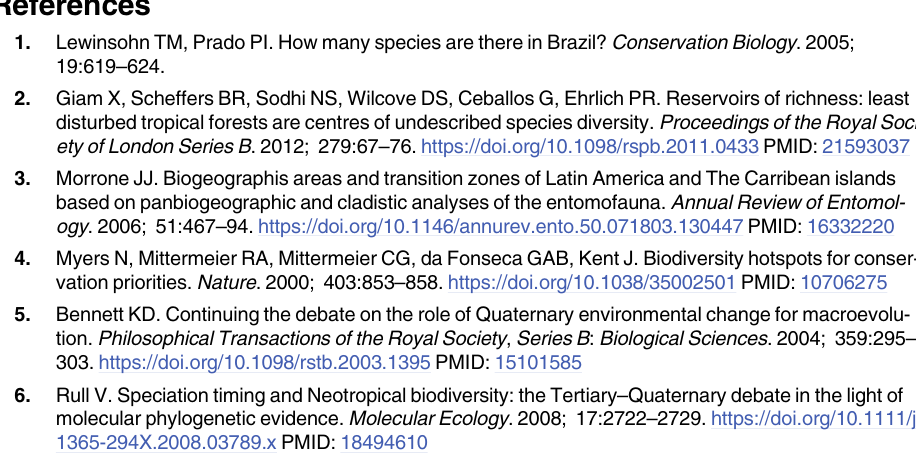
S14 Table. Estimates of relative contributions of each of the employed environmental vari- ables to the ENMs reconstructed for each of the three species of the M . projectans complex. S15 Table. Pairwise values of abiotic niche overlap estimated among the three species of the M . projectans complex according to Schoener’s D (D) (above diagonal) and Hellinger’s (I) (below diagonal)